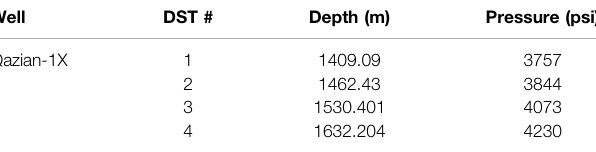
TABLE 3 | DST data of Murree Formation recorded in Qazian-1X well. A total of four DSTs are recorded in Murree Formation encountered in Qazian-1X well on the basis of oil shows observed during drilling (Law et al., 1998).